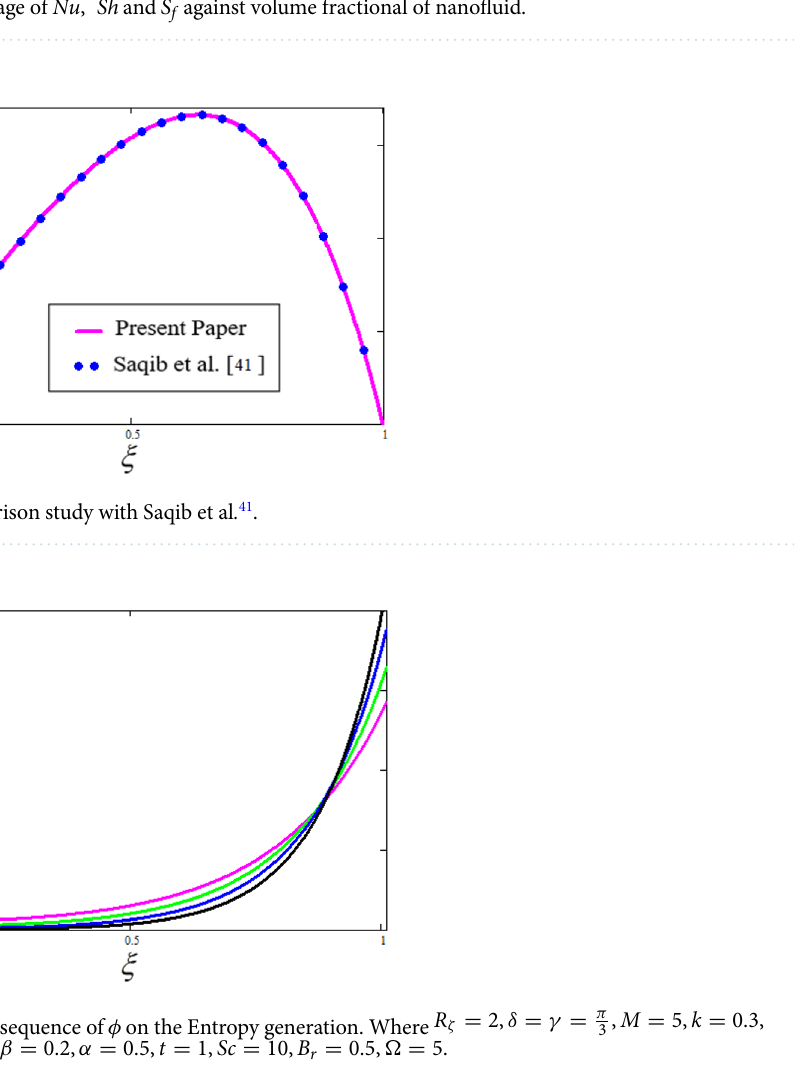
Figure 21. Percentage of Nu , Sh and S f against volume fractional of nanofluid.